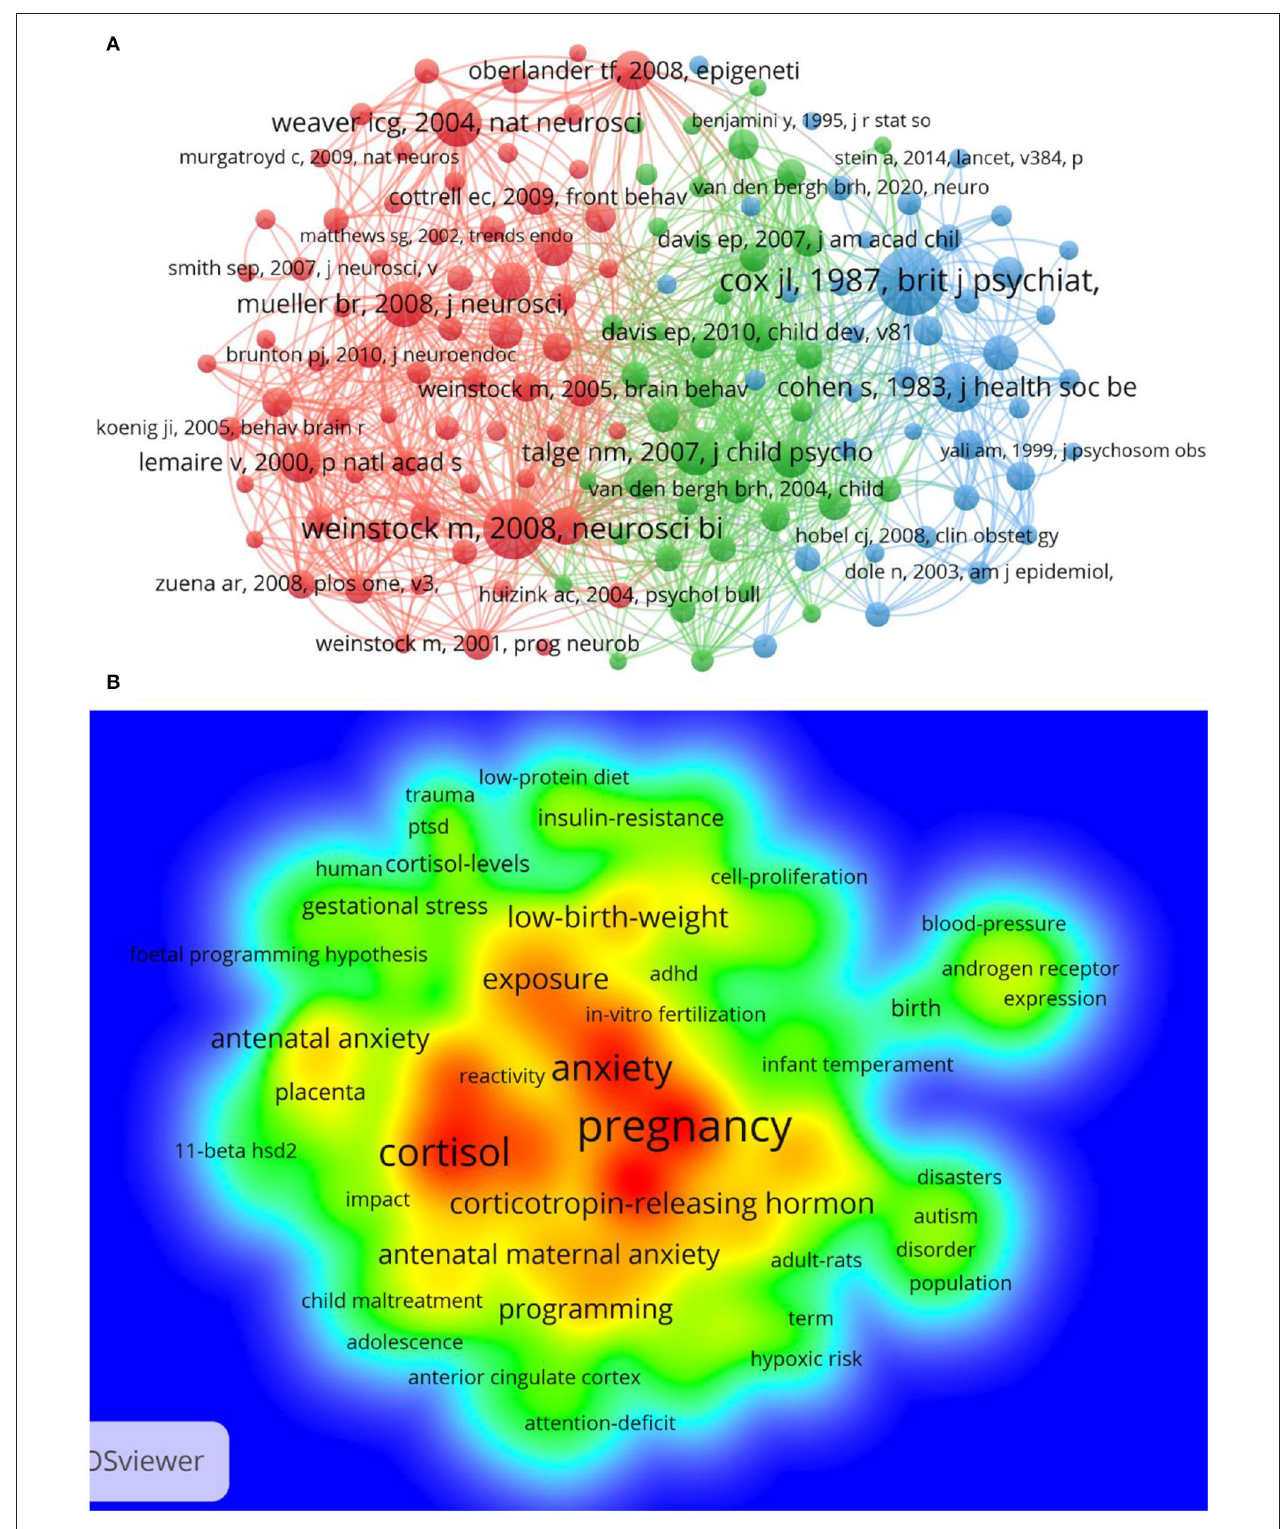
FIGURE 6 | Co-cited reference network of PS-related research. (A) Network of co-cited references. Of the 2,71,109 references, 149 references were cited at least 76 times. (B) Density visualization of keywords of cluster 2 in the network of co-cited references. Each keyword in density visualization has a color indicating its density. Red indicates high frequency, and yellow indicates low